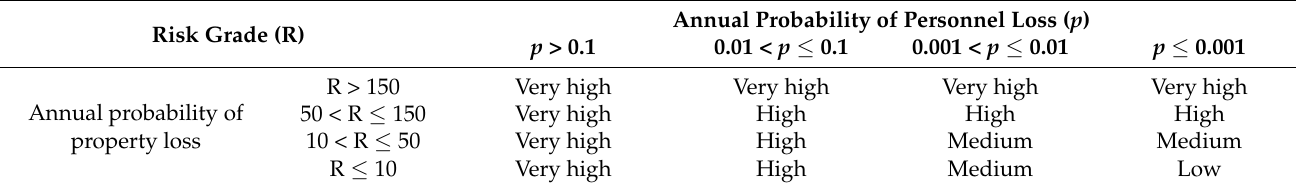
Table 9. Risk grading standard of the Boshuigou debris flow.